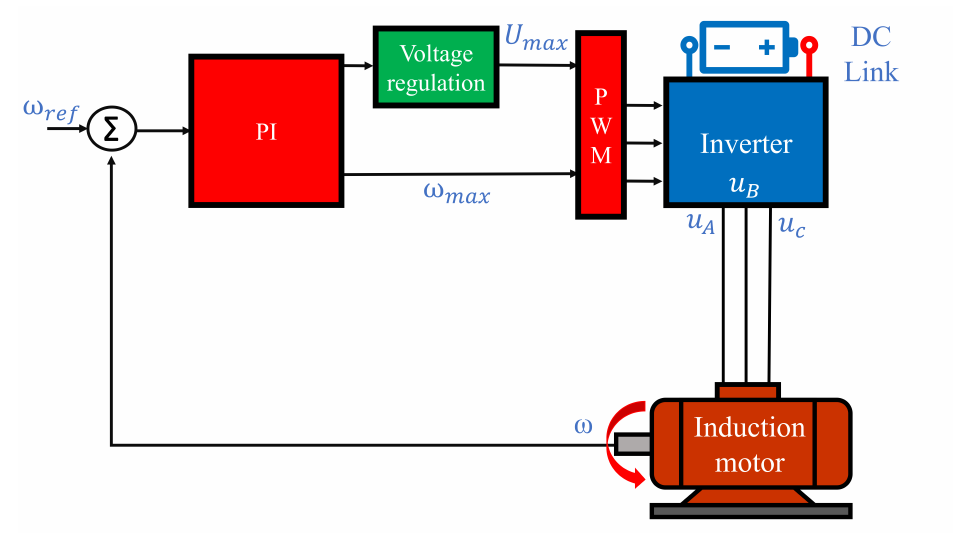
Figure 1. Schematics of the control system. On the other hand, the schematic representation of the control system used for vector control of the presented induction motor is presented in Figure 2.